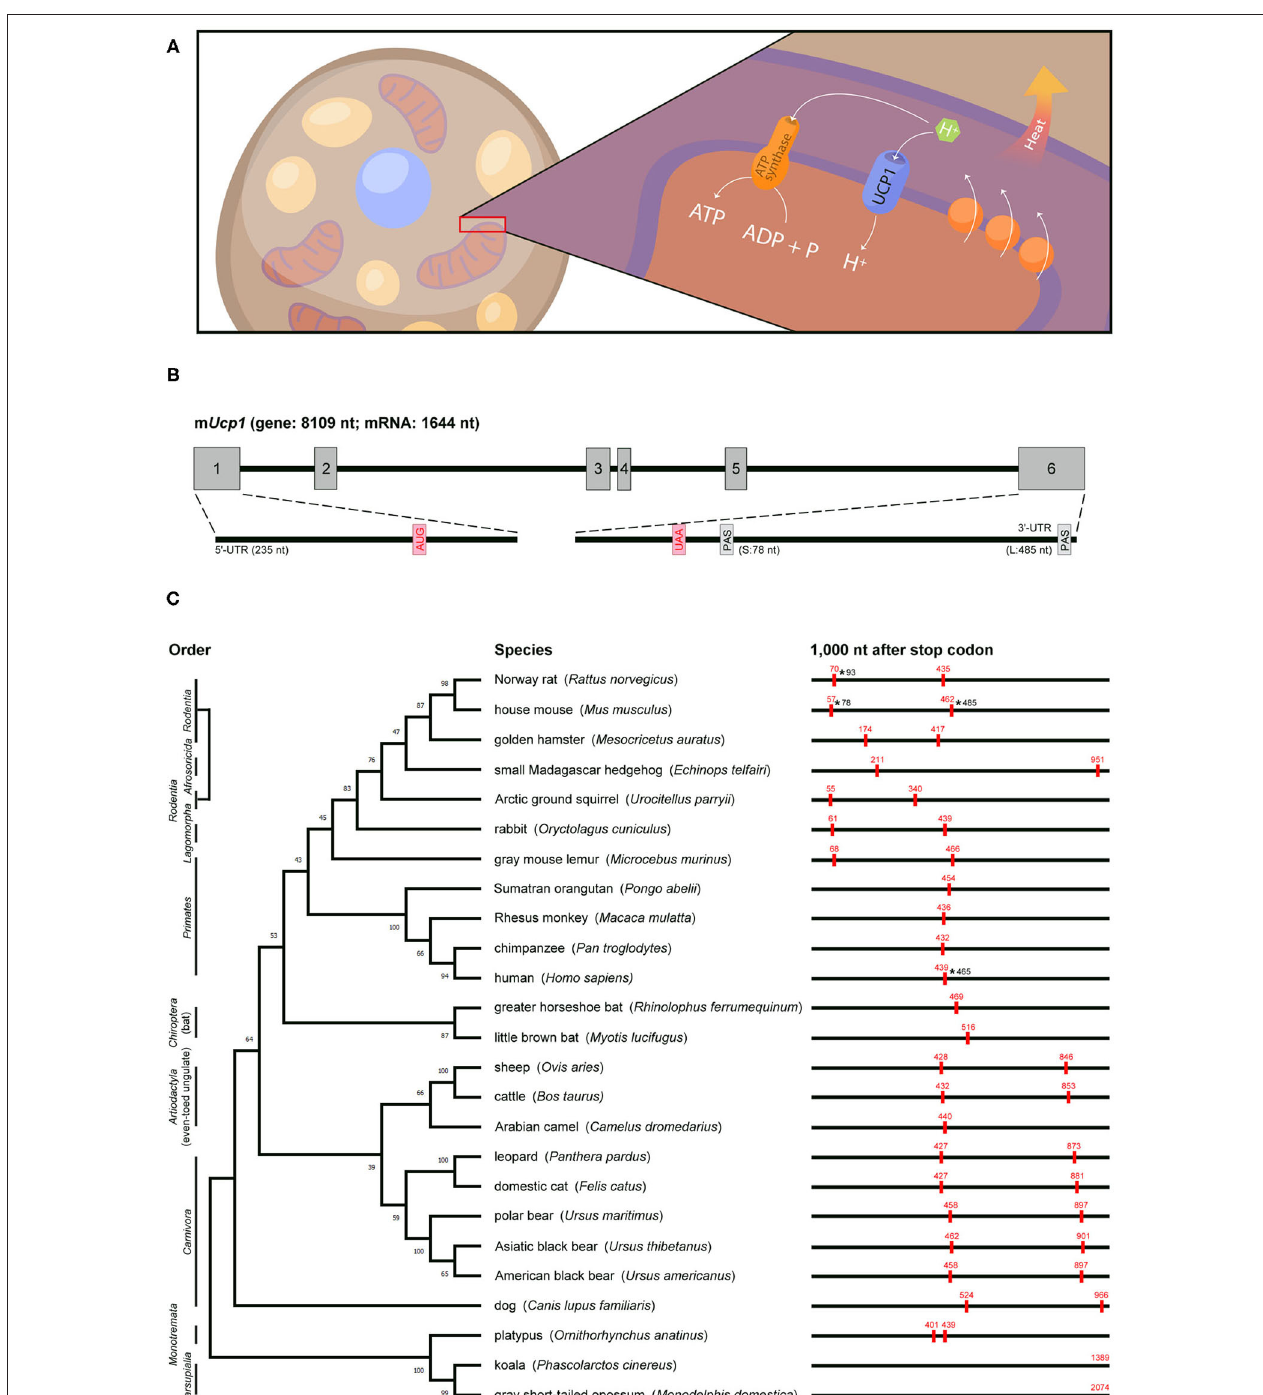
FIGURE 1 | Genomic information, actual or predicted polyadenylation sites in Ucp1 across species. (A) UCP1, a proton channel located in the inner mitochondrial membrane of brown adipocytes, transports protons to the matrix and then disrupts the proton gradient generated by the electron transport chain, thus uncoupling fuel oxidation from ATP synthesis and releasing energy as heat. (B) Mouse Ucp1 spans ∼ 8kb and contains six exons (gray boxes). The start (AUG) and stop (UAA) codons are labeled in red, and the two polyadenylation sites (PAS) are denoted. The 5 ′ -UTR and 3 ′ -UTR of Ucp1 are located on exons 1 and 6, respectively. (C) Phylogenetic relationship of mammalian Ucp1 by alignment of the nucleotide sequences of coding regions. Animal orders are marked in the left and the percentage of bootstrap support of minimum evolution is shown on the corresponding branch. The BLAST search of 1,000 nt after the Ucp1 stop codon across species involved the Ensembl or NCBI database. The poly(A) signals (AAUAAA) are marked as red boxes with their positions in red. The ends of 3 ′ -UTRs confirmed by cDNA sequencing in rat, mouse, and human are labeled with asterisks and numbers.